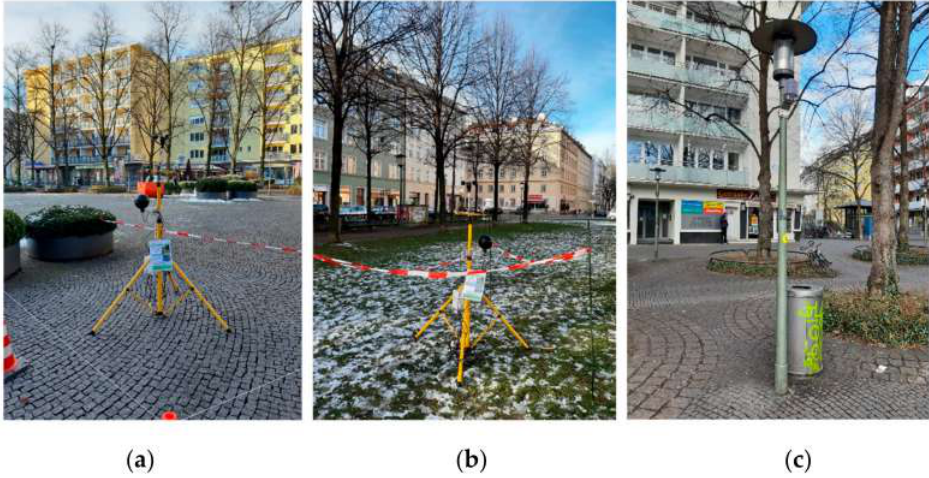
Figure 7. Winter field measurement. Hohenzollernplatz ( a ); Bordeauxplatz ( b ); iButton ( c ).